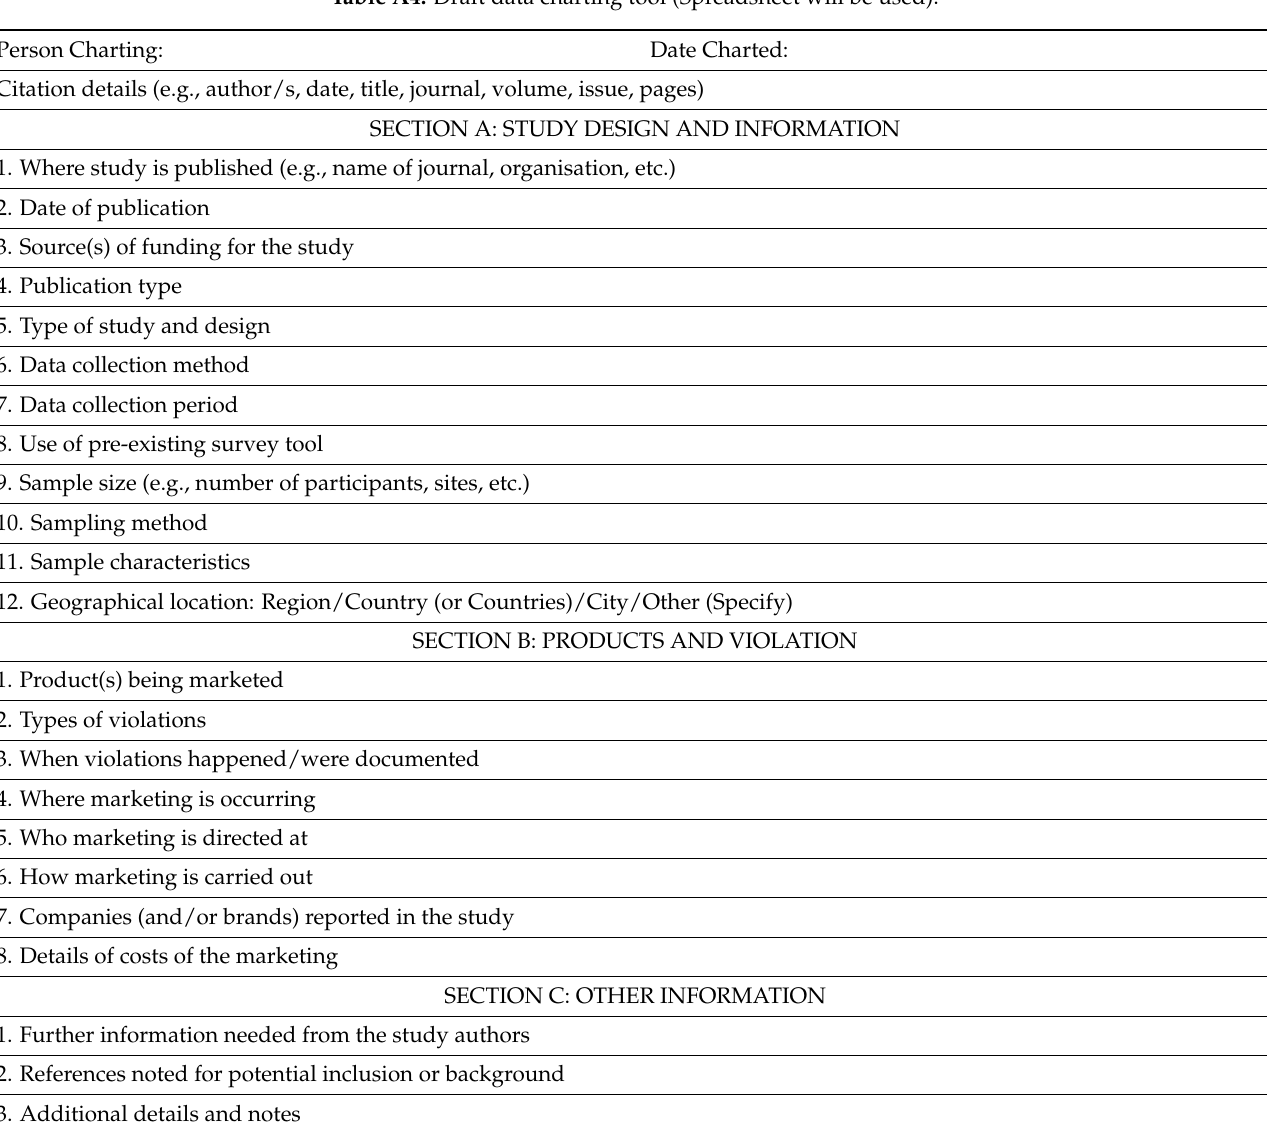
Table A4. Draft data charting tool (Spreadsheet will be